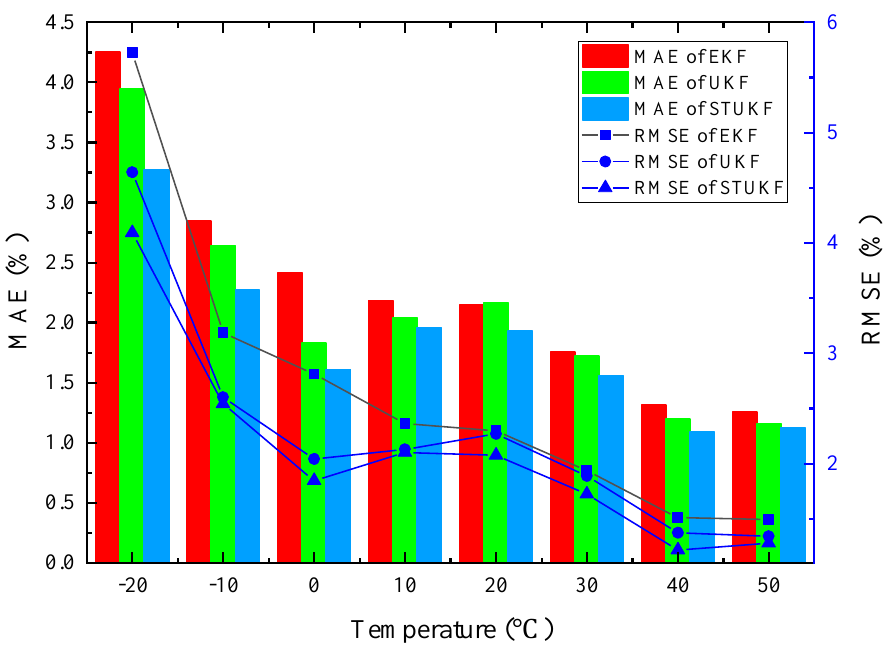
Figure 12. Comparative results of EKF, UKF, and STF for SOC estimation: ( a ) SOC estimation results; ( b ) the enlarged window from 4000 to 6500 s; ( c ) SOC estimation error.